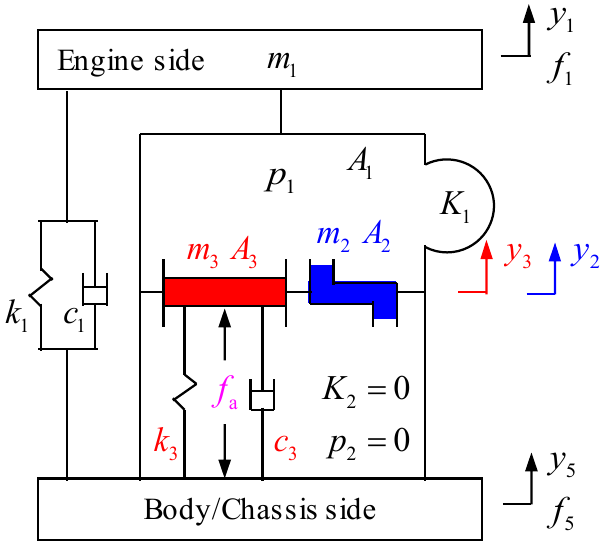
Figure 1. ACM mechanical model. Table 1. The parameters of the ACM with oscillating coil actuator (OCA).